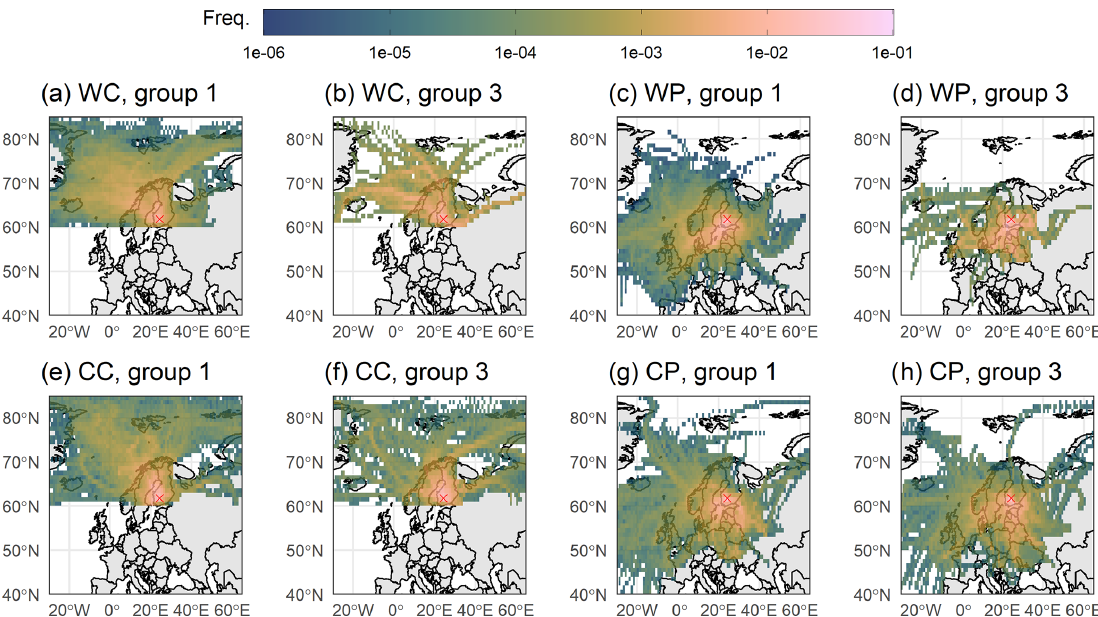
Figure 7. The 96h air mass history for the wet processing groups (1 and 3) with the sector (clean and polluted) and temperature (warm and cold) division. Subplots show (a, b) warm and clean, (c, d) warm and polluted, (e, f) cold and clean, and (g, h) cold and polluted. Colour scale shows the frequency (crossings in each 1 ◦ × 1 ◦ grid point divided by total number of crossings in each group) of trajectories crossing a grid point. The groups 1 and 3 correspond to the air mass history groups presented in Table 1. The red cross shows the location of SMEAR